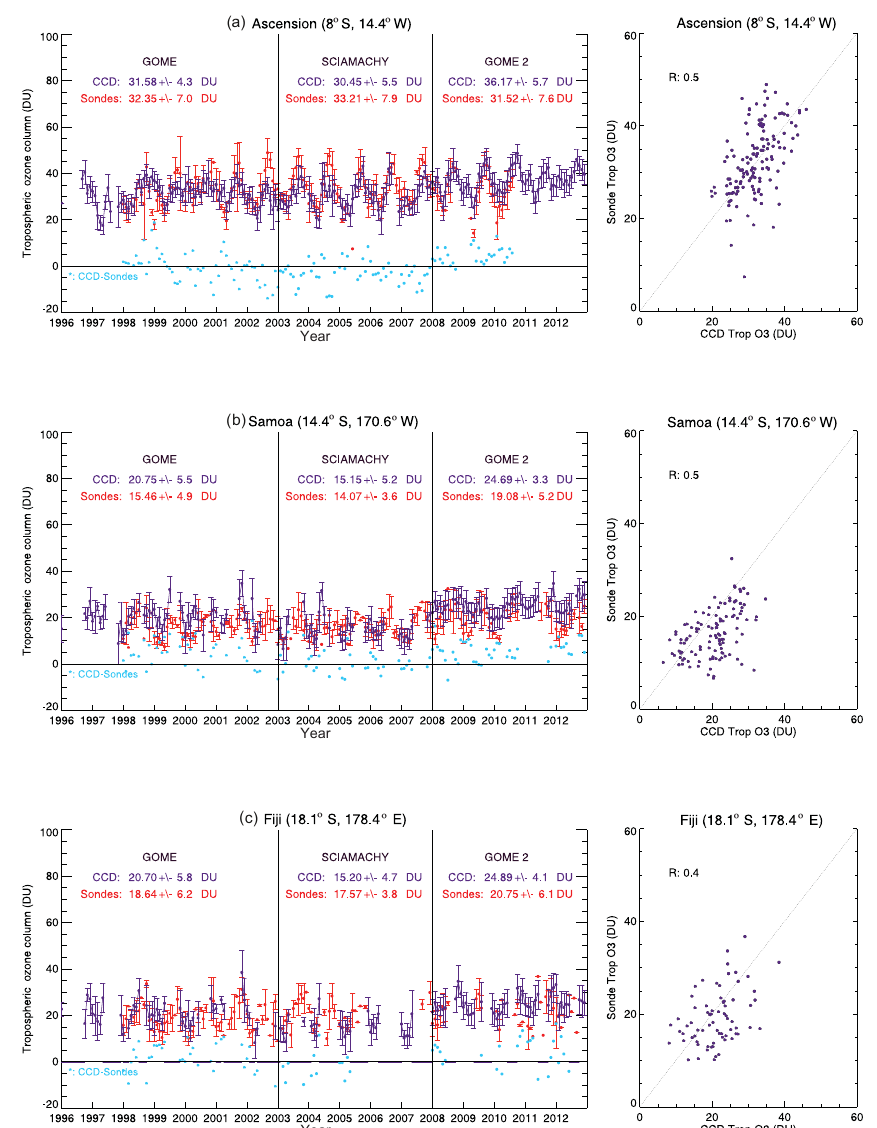
Figure 14. Time series of monthly-mean CCD tropospheric ozone columns and collocated monthly-mean SHADOZ ozonesonde TTCO in Ascension, Samoa, and Fiji (from top to bottom). The red lines give the integrated ozone column from sonde ozone up to the fixed level of 200hPa (roughly 12km). The blue lines are: (i) GOME-1 CCD ozone columns (1996–2002), (ii) SCIAMACHY CCD ozone columns (2003–2007), and (iii) GOME-2 CCD ozone columns (2008–2012). Error bars indicate the standard deviation of the monthly mean. No error bars are shown for months with only one ozonesonde launch available. The difference between CCD and ozonesondes is plotted with light blue